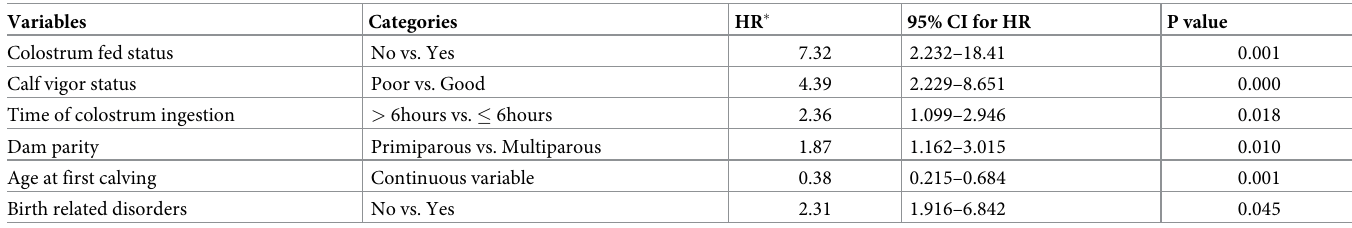
Table 7. Potential risk variables significantly associated with incidence of crude morbidity based on multivariable analysis using Cox regression.